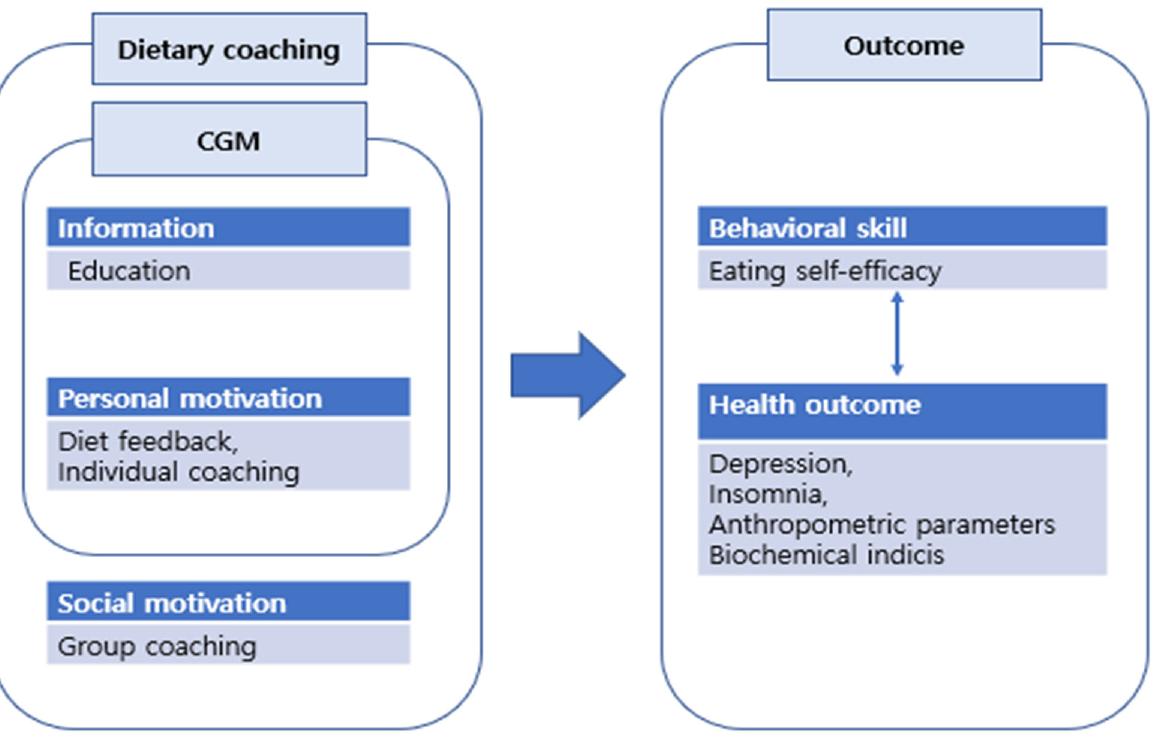
Figure 2. Conceptual framework including the research outcome measures.